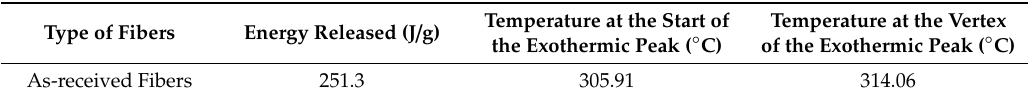
Table 1. DSC data of as-received